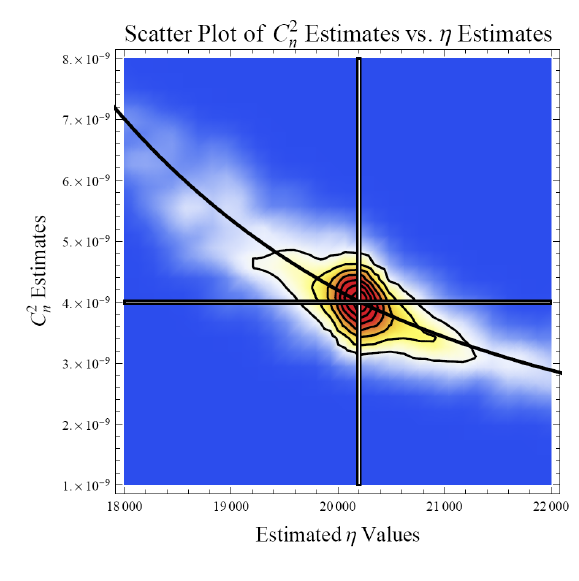
Fig. 10. Contour-scatterplot of C 2 η 1η estimates versus η 1 esti- mates. The horizontal and vertical lines indicate the true value val- ues for those parameters, respectively. The solid black curve is from Eq.